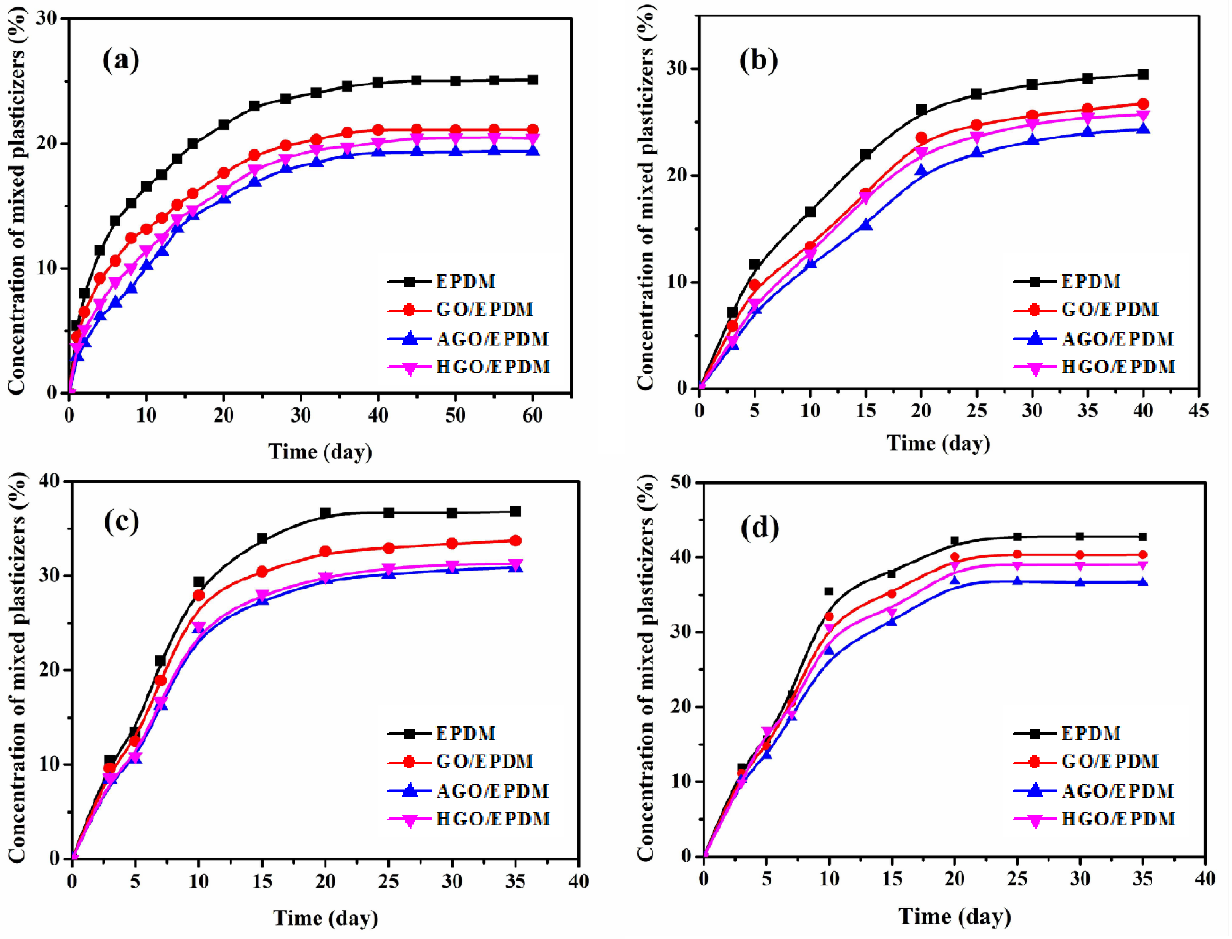
Table 1. Equilibrium concentration of the mixed plasticizers in the insulation.